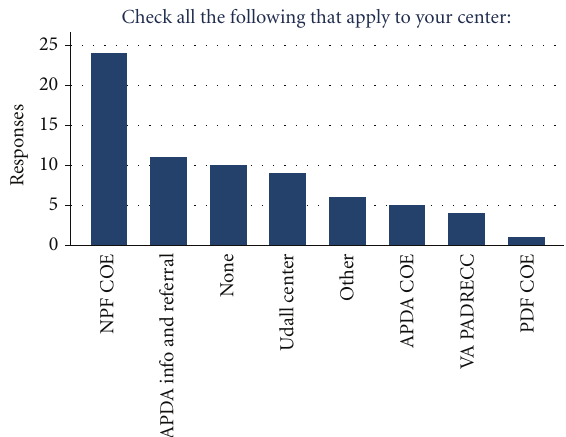
Figure 1: Special designations with respect to research or clinical